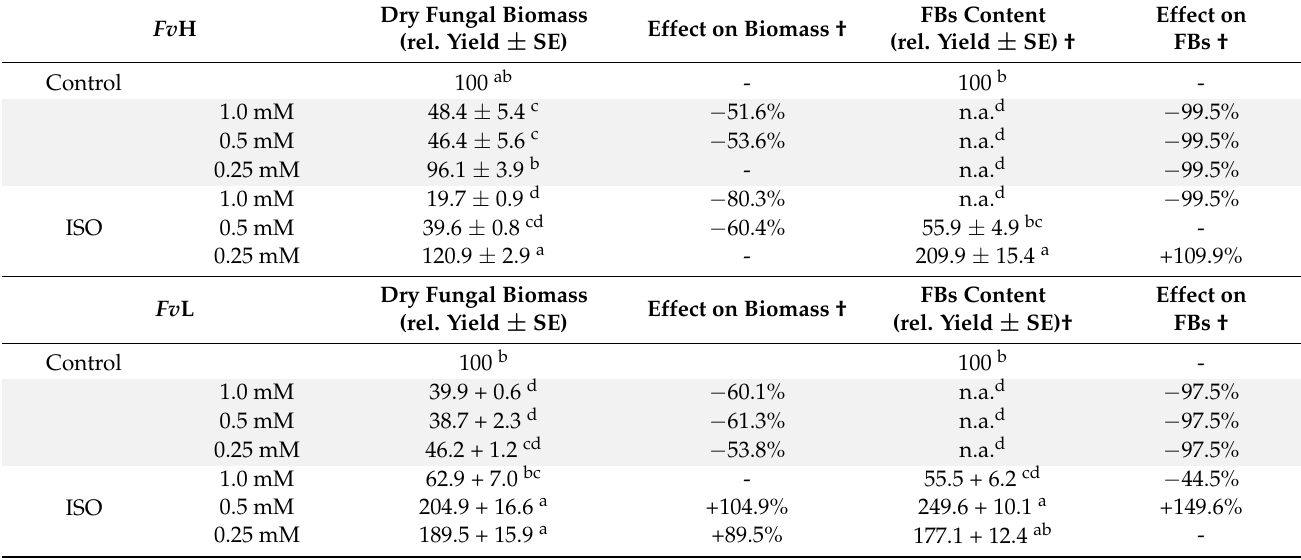
Table 3. In vitro effect of ELL and ISO treatments (1.0, 0.5, and 0.25 mM) on fungal growth and fumonisin production. Fv H